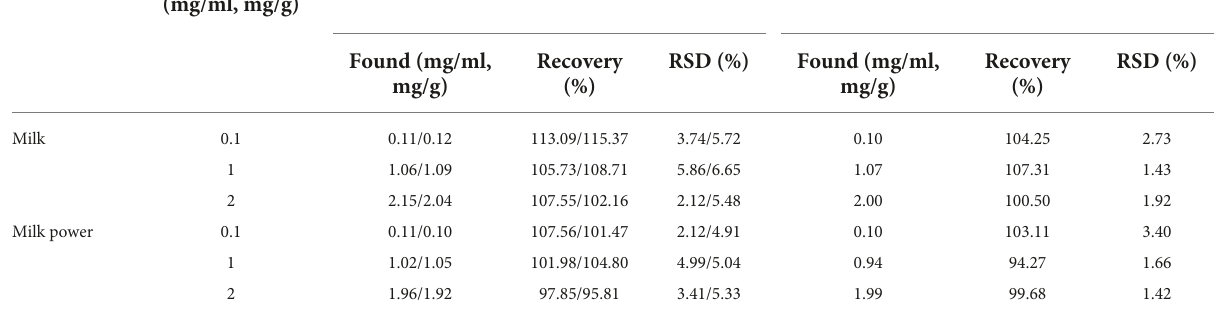
TABLE 2 Determination of α -lactalbumin in spiked food